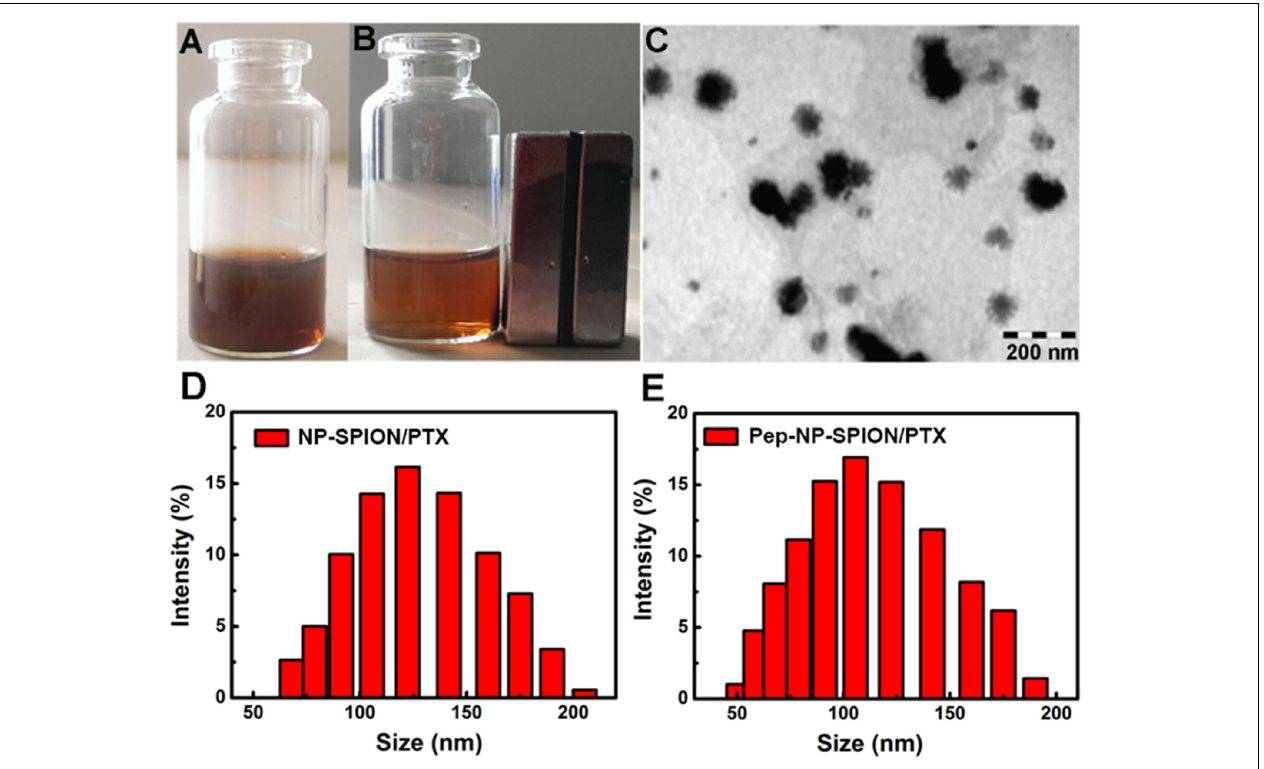
FIGURE 3 | Characterization of Pep-NP-SPION/PTX. Pep-NP-SPION/PTX solution (A) or absorption under external magnetic field (B) ; TEM image of Pep-NP-SPION/PTX (C) and size distribution of NP-SPION/PTX (D) and Pep-NP-SPION/PTX (E) .